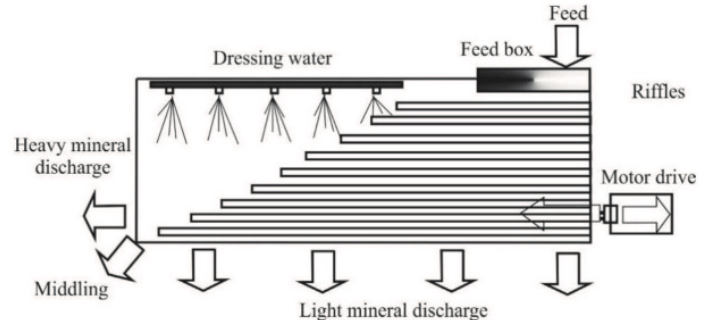
Figure 1. Schematic illustration of the arrangement of a riffled shaking table; note the feed input at the top right corner of the